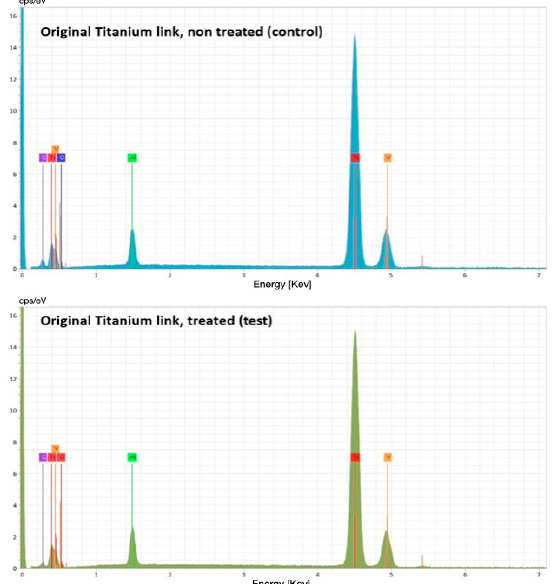
Figure 8. Energy-Dispersive X-ray Spectroscopy (EDS) graph (R&D Nobil Metal SpA, Italy).